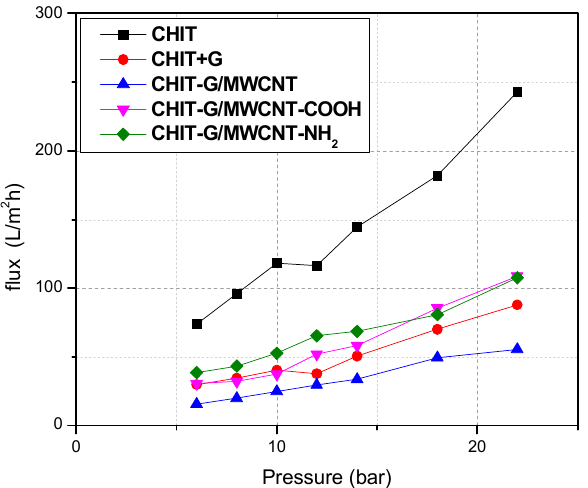
Figure 3. Flux plotted against transmembrane pressure for membranes.